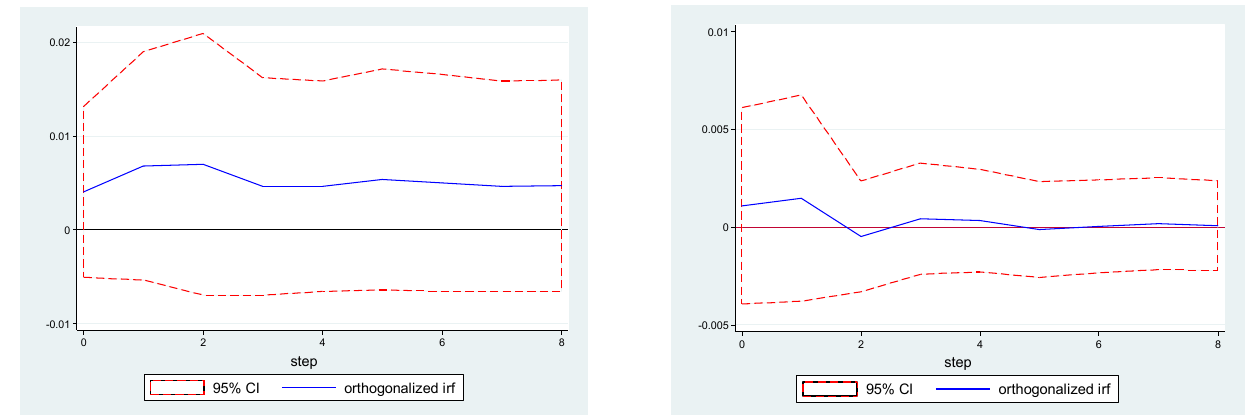
Figure 5. Impulse Response of lnCurrency to Expect and Shortcapital to lnCurrency. Table 5. VAR model